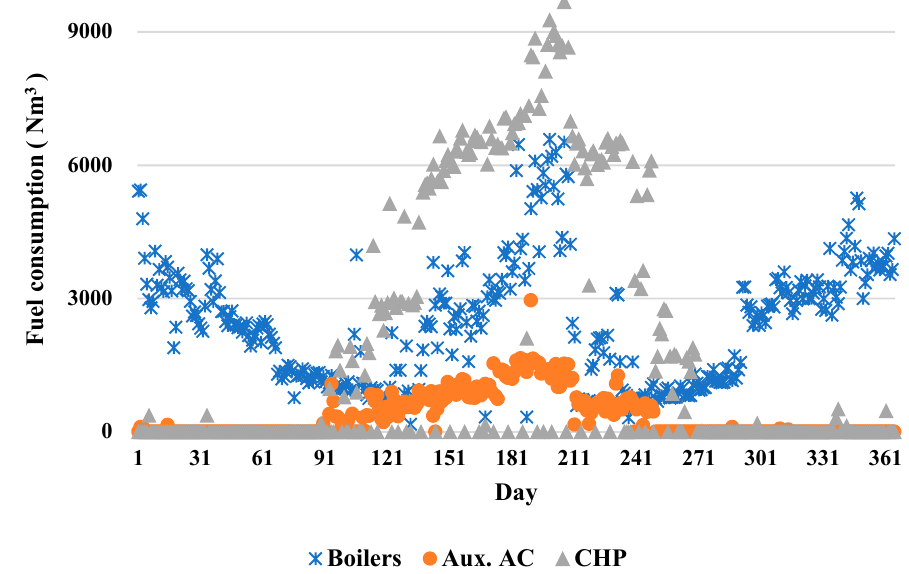
Figure 7. Annual daily fuel consumption profile for each facility for Case B.